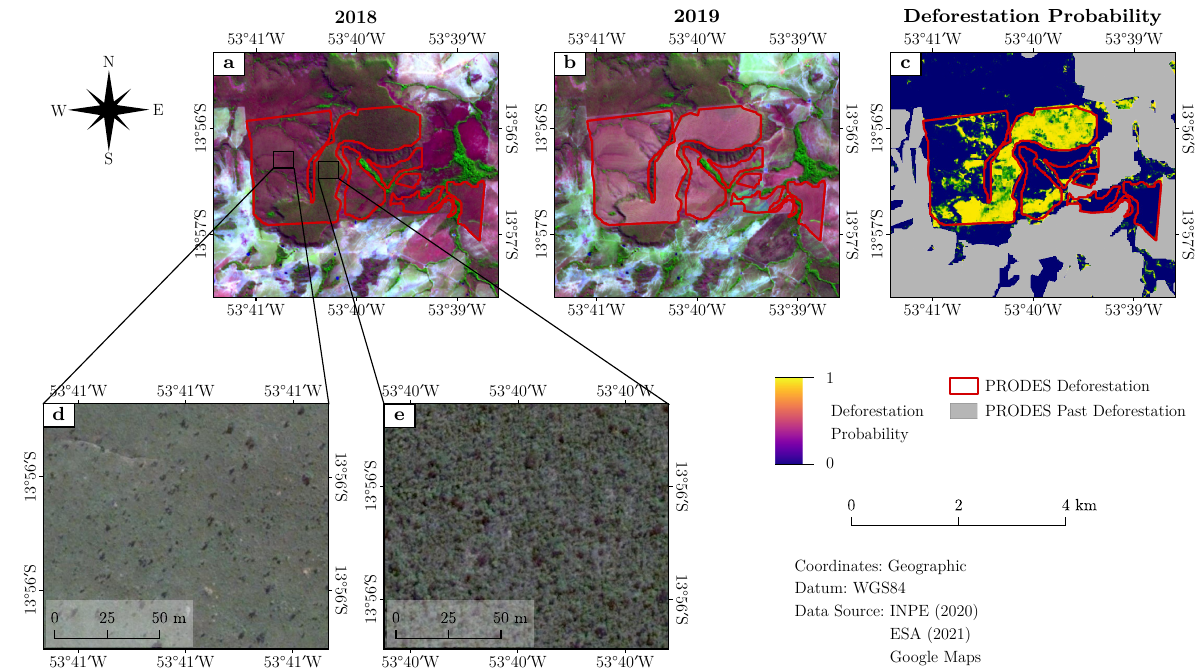
Figure 11. ( a , b ) RGB (Band 11, Band 8, Band 4) Sentinel-2/MSI images acquired on 3 July 2018 and 3 July 2019 (during the dry season), respectively, overlaid on PRODES de- forestation polygon for the Mato Grosso study area (2019). ( c ) is the LSTM deforestation probability map overlaid on PRODES deforestation polygon and PRODES past deforestation. ( d , e ) are Google Earth images of natural vegetation during dry season prior to the deforestation in 2019, in which the first one is a Grassland Formation and the other is a Savanna Formation. LSTM deforestation probability maps are more accurate for Savanna